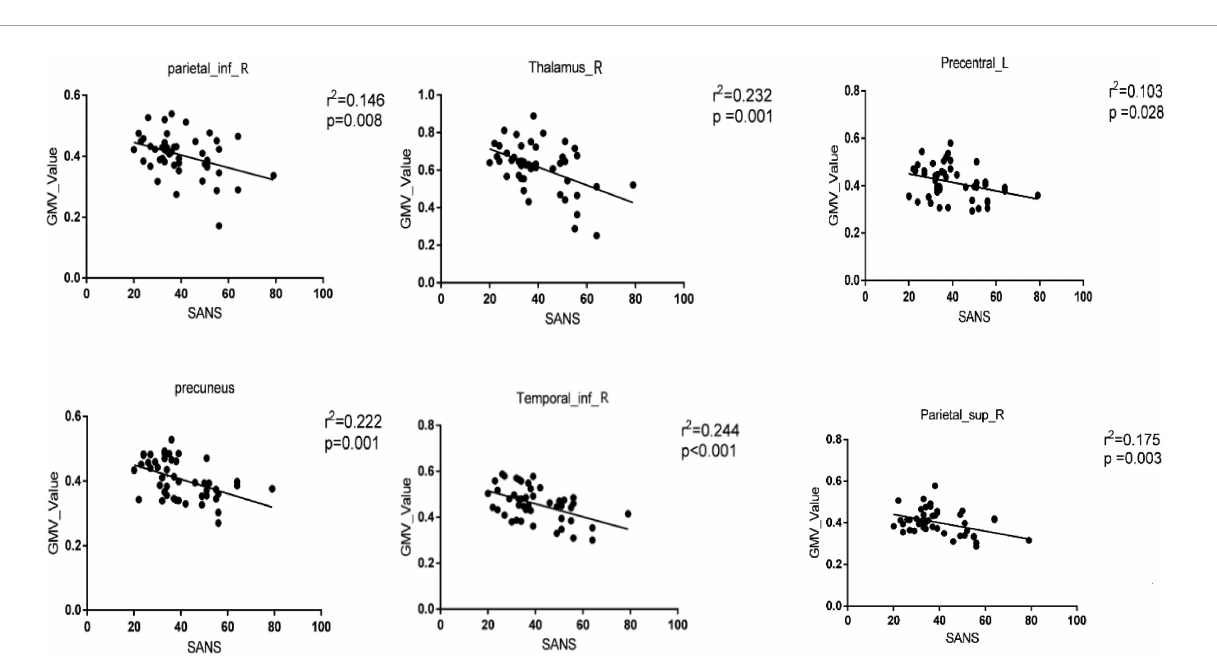
FIGURE2 Significant correlations between the gray matter volume (GMV) values of brain regions with classification weights in the top 1% and clinical features in the whole patient group [deficit schizophrenia (DS) group and non-deficit schizophrenia (NDS) group]. The significance threshold was set at p < 0.05 (uncorrected). Parietal_inf_R, right inferior parietal lobule; Thalamus_R, right thalamus; Precentral_L, left precentral gyrus; Temporal_inf_R, right inferior temporal gyrus; Parietal_sup_R, right upper parietal